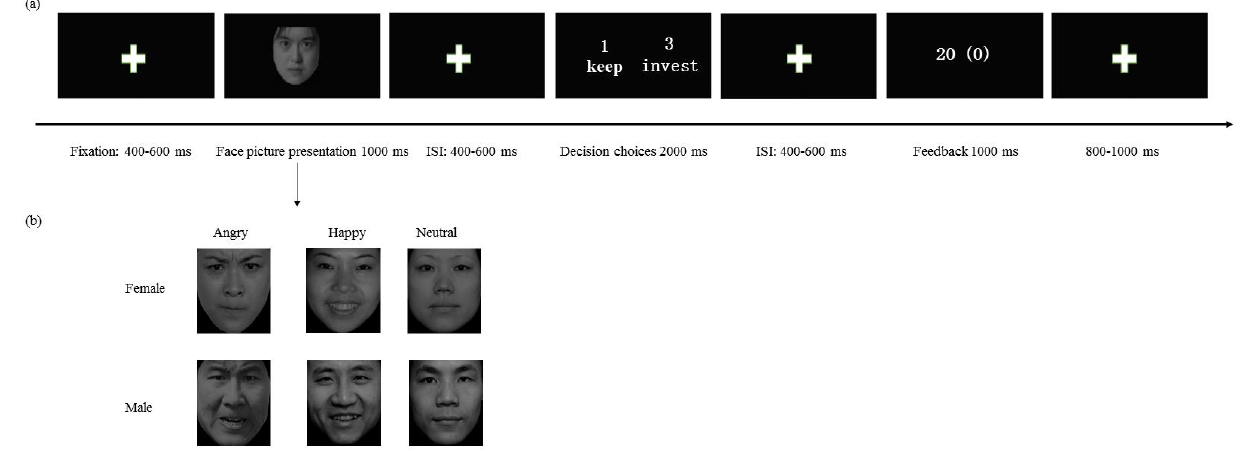
Figure 1. ( a ): Time sequence of stimuli in each trial of the decision task. Positions of 1 (distrust) and 3 (trust) for decision choices were counterbalanced between participants. Loss feedback was 0, and 20 was gain feedback. ISI = interstimulus interval; ITI = intertrial interval. ( b ): The photos of trustees differed regarding the emotional type (i.e., happy, angry, or neutral) and gender (i.e., female or male).